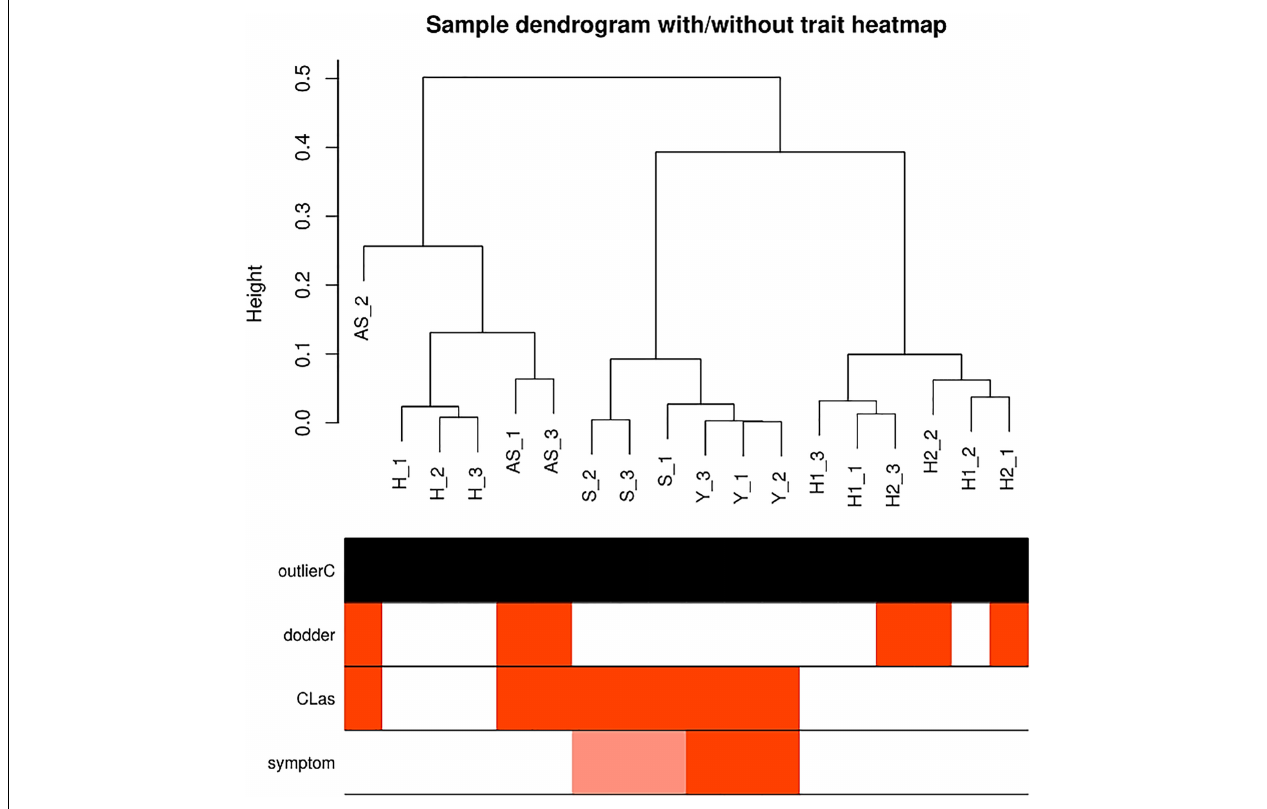
FIGURE 2 | Sample correlations evaluated with dendrogram. Red bars in each row indicate samples in relation to factors, including dodder, CLas and symptom. None is detected as outlier samples. H1, healthy periwinkle not parasitic with healthy dodder as control; H2, healthy periwinkle parasitic with healthy dodder as control; AS, asymptomatic periwinkle infected with CLas by dodder-mediated transmission. H, healthy periwinkle leaves; S, symptom just occurred partially mottled leaves; Y, yellow periwinkle leaves.